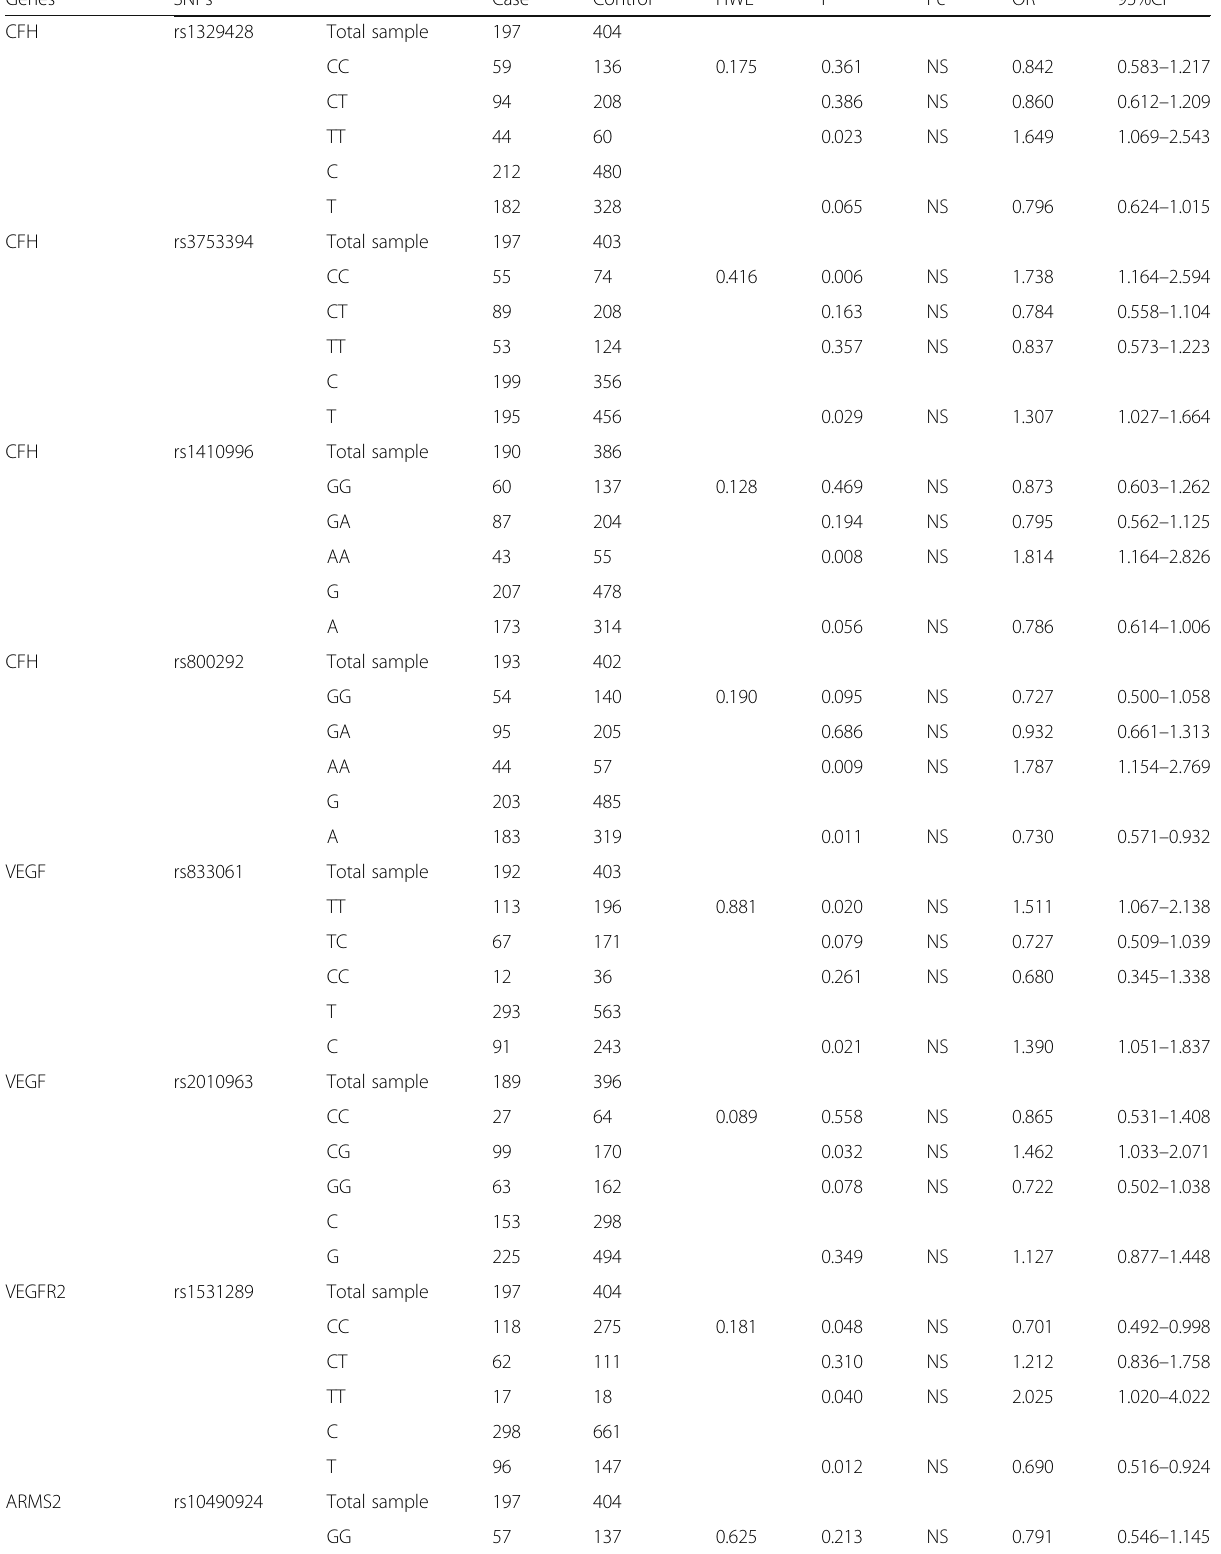
Table 2 Genotype and allele frequencies of ten genes ’ polymorphism in AMD and healthy controls